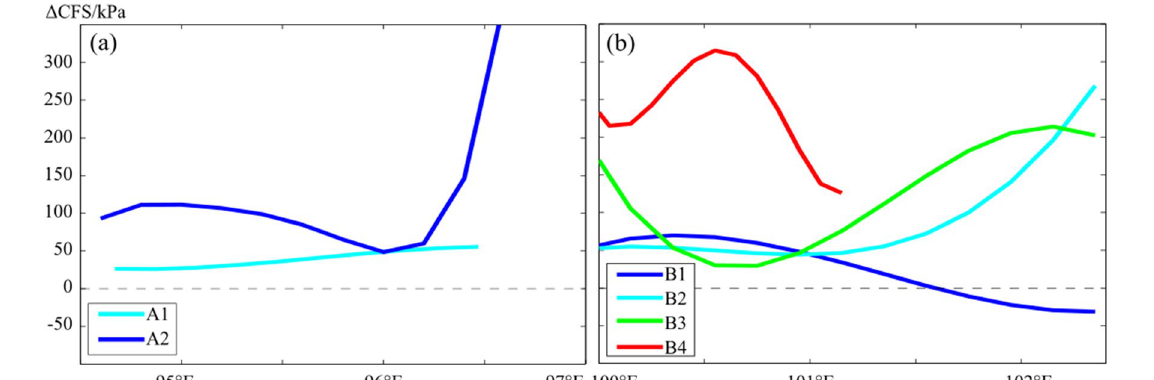
Fig. 8 The combined ΔCFS on gap A and gap B area